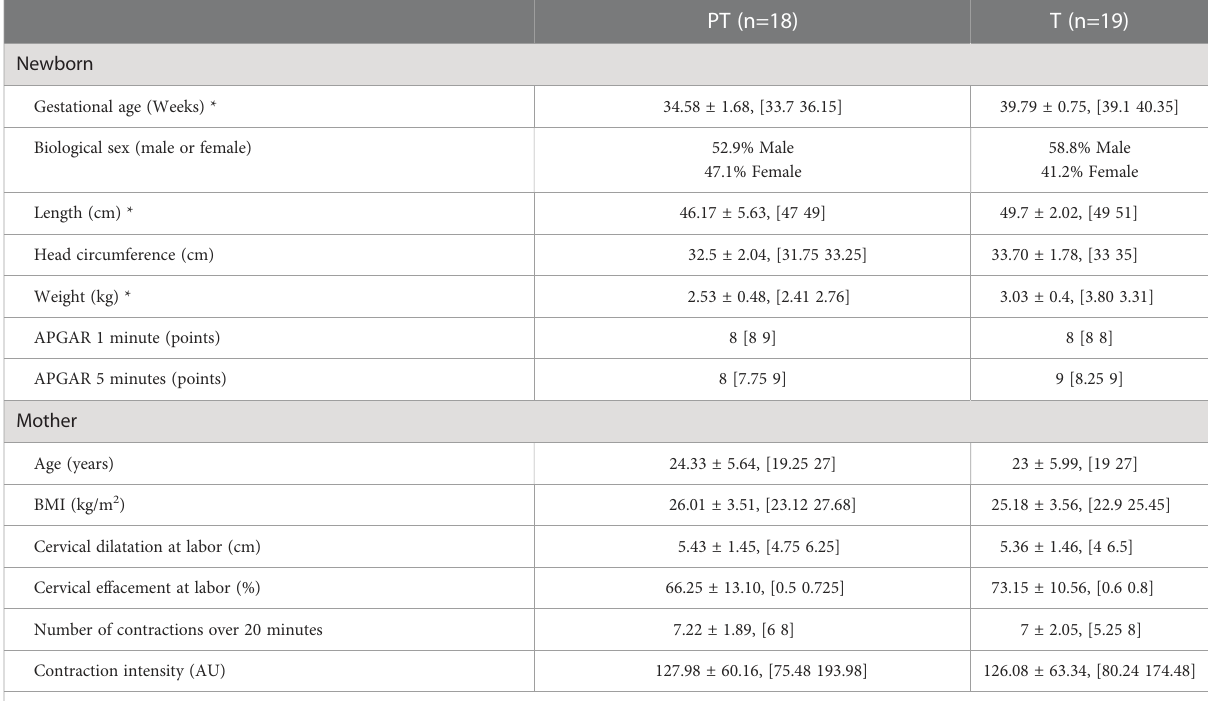
TABLE 1 Clinical characteristics of newborns and mothers for Term (T) and Preterm (PT) groups (mean +/-SD), and interquartile